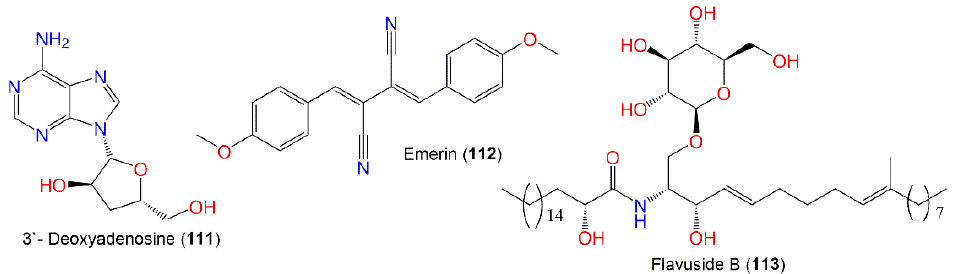
Figure 10. Structures of other nitrogenous compound ( 111 – 113 ) alkaloids. The cerebroside, flavuside B ( 113 ), reported from orange peel-associated E. nidulans , had no antimalarial, antimicrobial, or antileishmanial capacities [68] (Table 8).